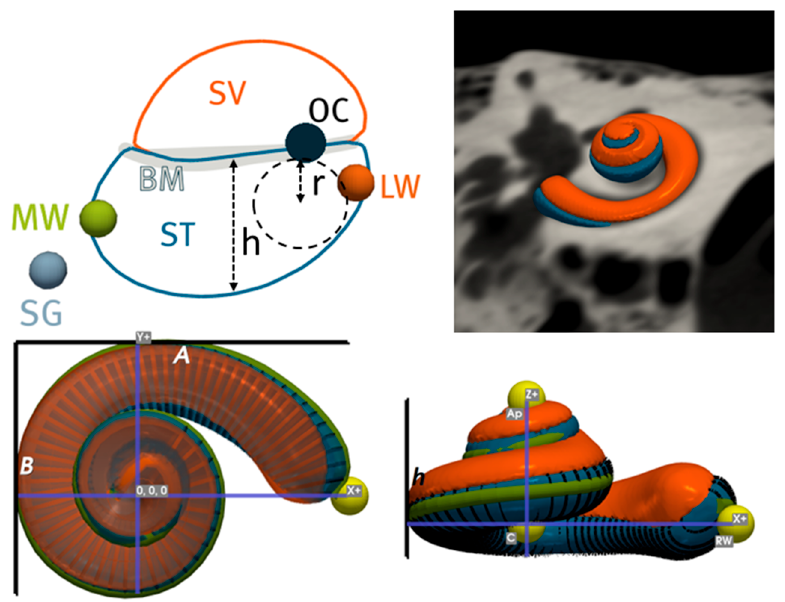
Figure 1. Description of clinical metrics computed by Nautilus. A: maximum length between round window and lateral wall; B: maximum perpendicular length to A. h: height of cochlea; h: maximum vertical ST height; r: radius of maximum circle that can fit in ST; ST: scala tympani; SV: scala vestibuli; BM: basilar membrane; OC: organ of corti; LW: lateral wall; MW: modiolar wall.